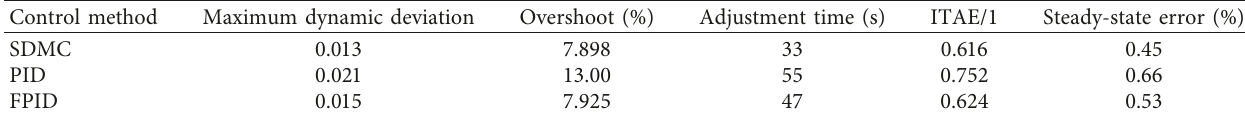
Table 3: Comparison of different control